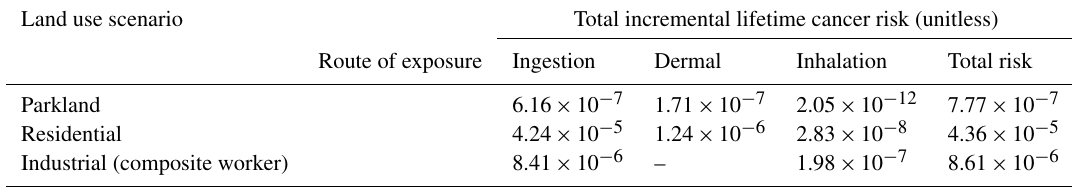
Table 7. Calculated TILCRs based on different routes of exposure and land use scenarios (sum of children and adults). Land use scenario Total incremental lifetime cancer risk